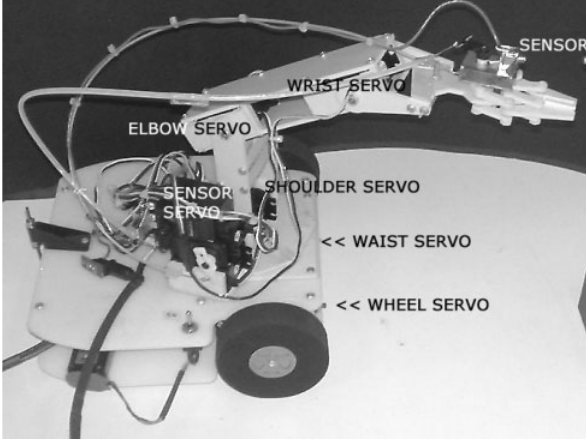
Figure 3 Detail of the payoff, decision and action functions of a SIM. PAYOFF FUNCTION: The light intensity (as digital voltage) feeds a substracter and actualizes a “last intensity” variable. The output of the subtracter or the payoff of the last movement of the robot is transformed into a payoff value by a sign function. The output of this last function is + 1 or − 1. A zero value output is produced when the payoff of the movement is in a range near zero difference. DECISION FUNCTION: The payoff value is fed to a “Two arm bandit algorithm”. This algorithm has this input and the last value decided by the algorithm. The value output identical to the last decision value when both inputs are the same; otherwise, the algorithm switches to the opposite last decision. ACTION FUNCTION: The output decision value is + 1 or − 1. This value is multiplied by a step value and fed to an adder that produces the signal to the corresponding servo and actualizes the last action value. The three functions are nested into a while function that re-enters when the payoff value is